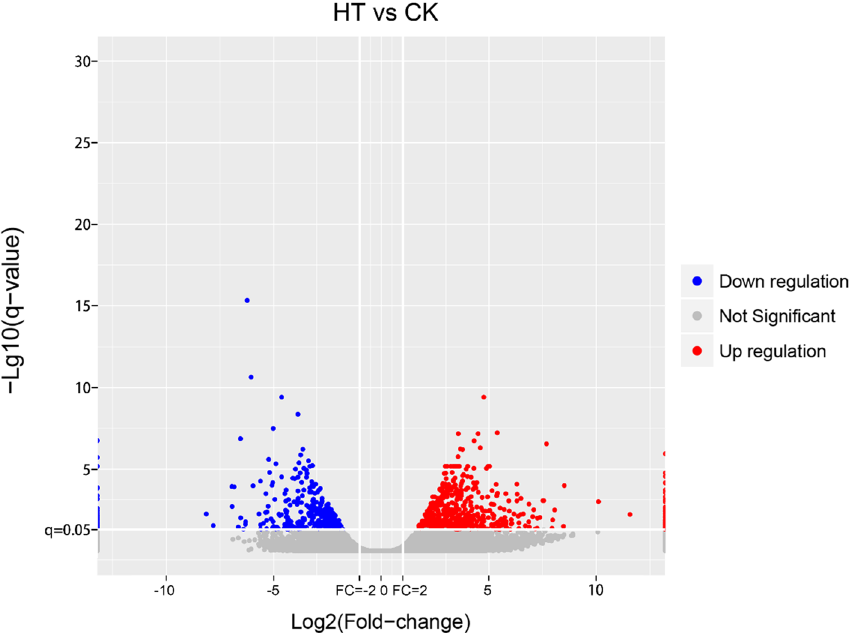
Figure 3. Volcano plot of differentially expressed transcripts with high-temperature stress treatment in S. pohuashanensis at q-value ≤ 0.05. Up-regulated and down-regulated genes were represented by red and blue dots, respectively.